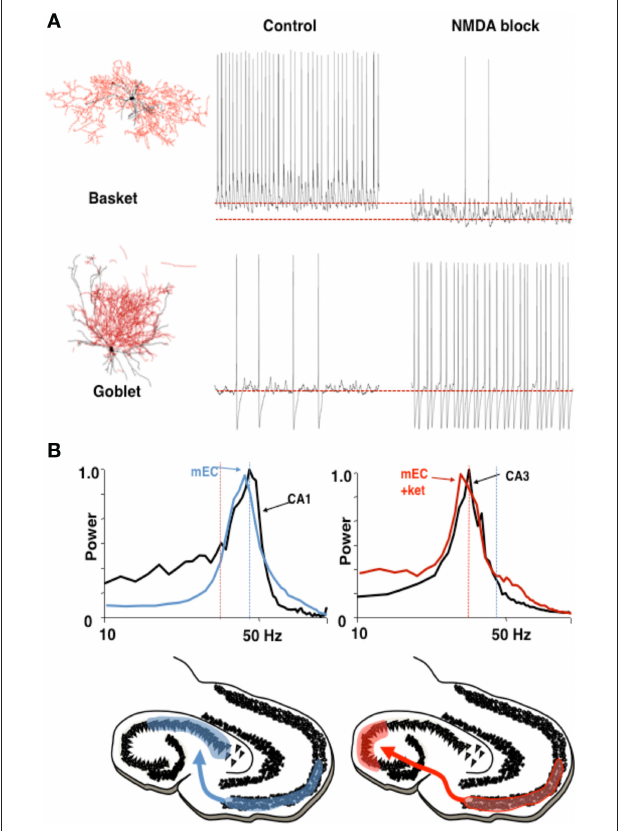
Figure 5 | Different rhythms may allow routing of cortical information flow. (A) Medial entorhinal cortex (mEC) generates two different frequencies of gamma rhythm depending on the degree of NMDA receptor-mediated excitation present. In control conditions a c. 40 Hz gamma rhythm is mediated by activity in layer 2 basket cells. In the absence of NMDA receptor-mediated excitation these interneurons become relatively hyperpolarized. The reduction in this source of phasic inhibition allows a second type of interneuron (layer 3 goblet cells) to become active, mediating a lower frequency (c. 30 Hz) gamma rhythm. Examples of reconstructed interneurons of both types and 1 s epochs of intracellularly recorded activity during local gamma rhythm generation are shown. (B) The two gamma rhythms in mEC have modal peak frequencies which correspond to the main resonant frequency of either the hippocampal CA1 or CA3 subnetworks during gamma generation. Spectra show that, in control conditions (NMDA present), mEC frequency matches that of area CA1. In the absence of NMDA drive mEC frequency matches that of area CA3. Below are cartoons illustrating the possible consequences for information flow into hippocampus. Figure from Middleton et al.